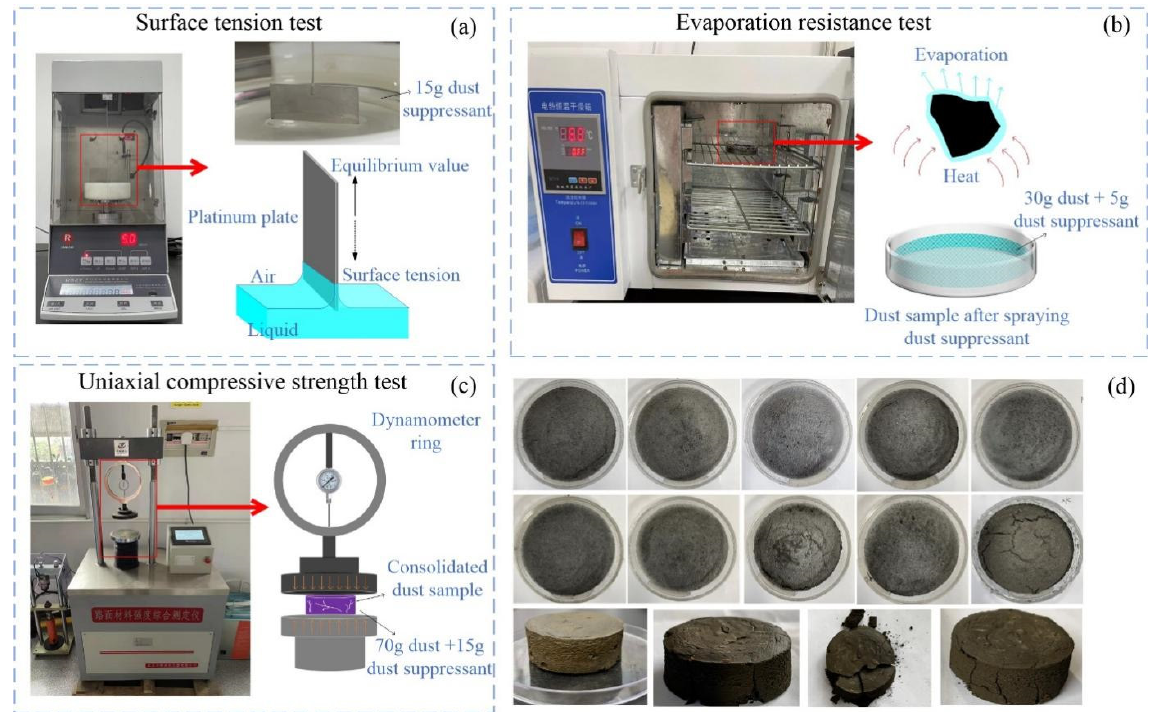
Figure 4. Test method of nano-composite dust suppressant performance. ( a ) Surface tension test. ( b ) Evaporation resistance test. ( c ) Uniaxial compressive strength test. ( d ) Experimental pictures. The surface tension of dust suppressant solution is measured three times by surface tension meter, and the average value is the final result, as shown in Figure